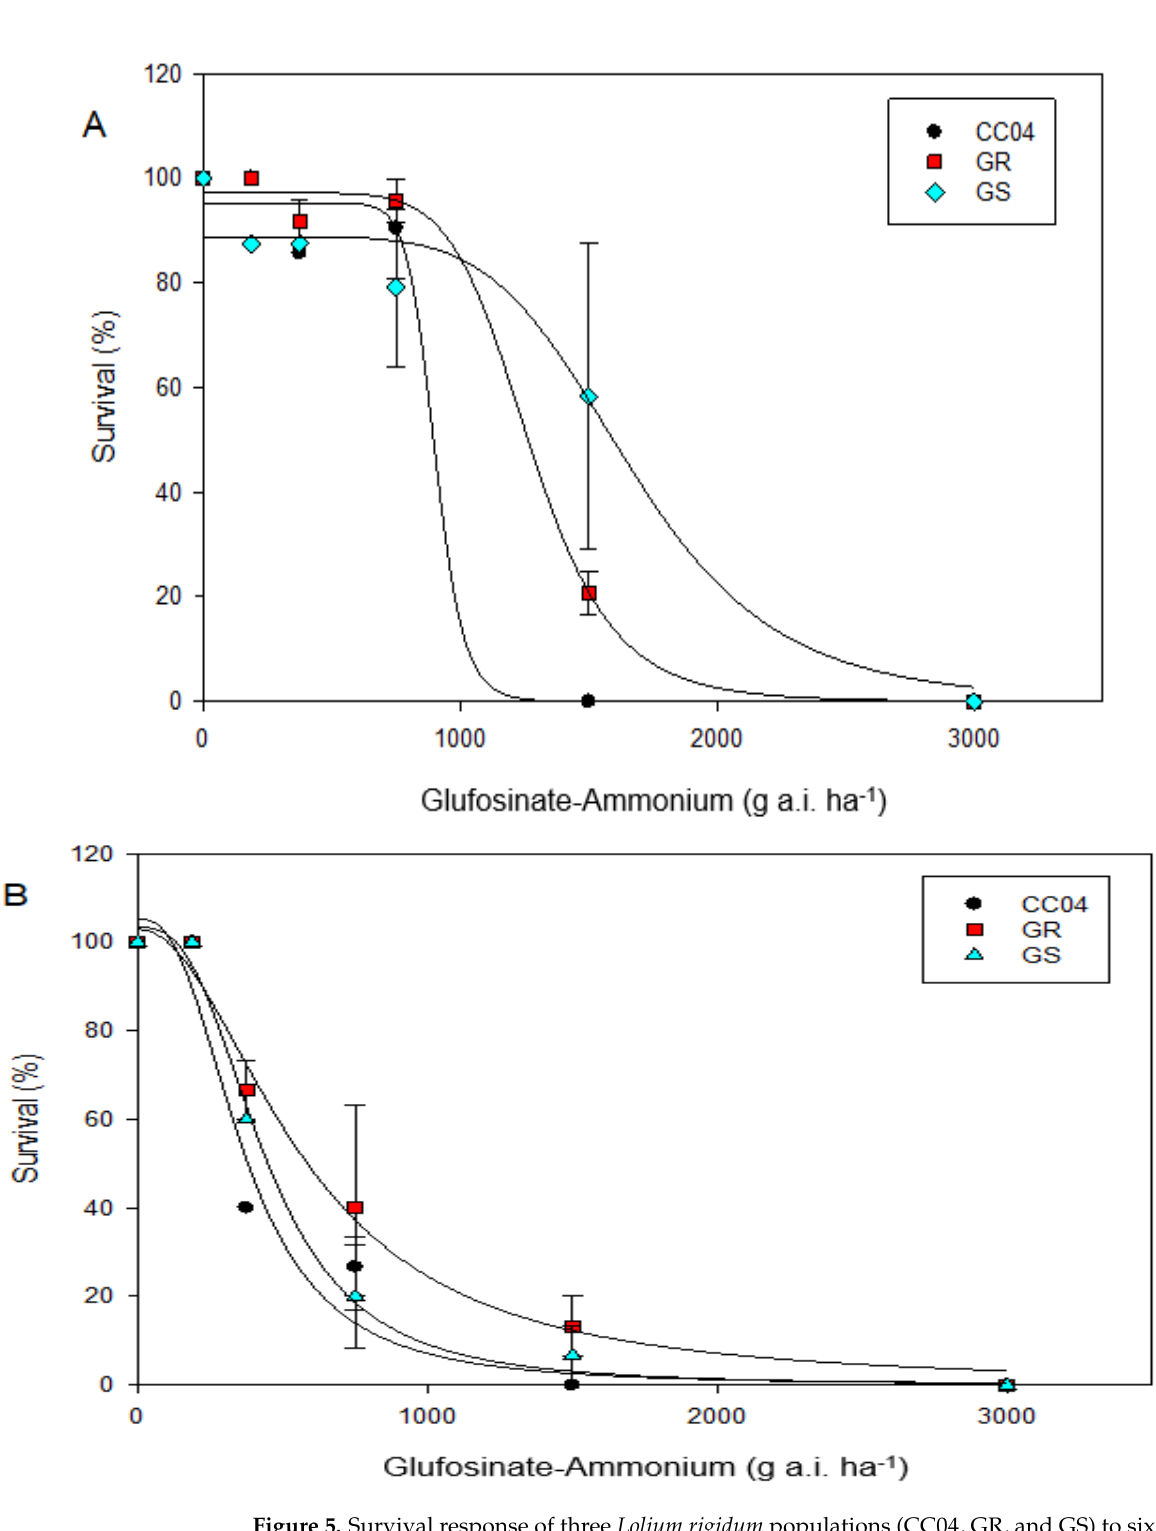
Figure 5. Survival response of three Lolium rigidum populations (CC04, GR, and GS) to six rates of glufosinate in ( A ) 2019 and ( B ) 2021. Data are presented as the average percentage of plants that survived and error bars represent the standard error of the mean.